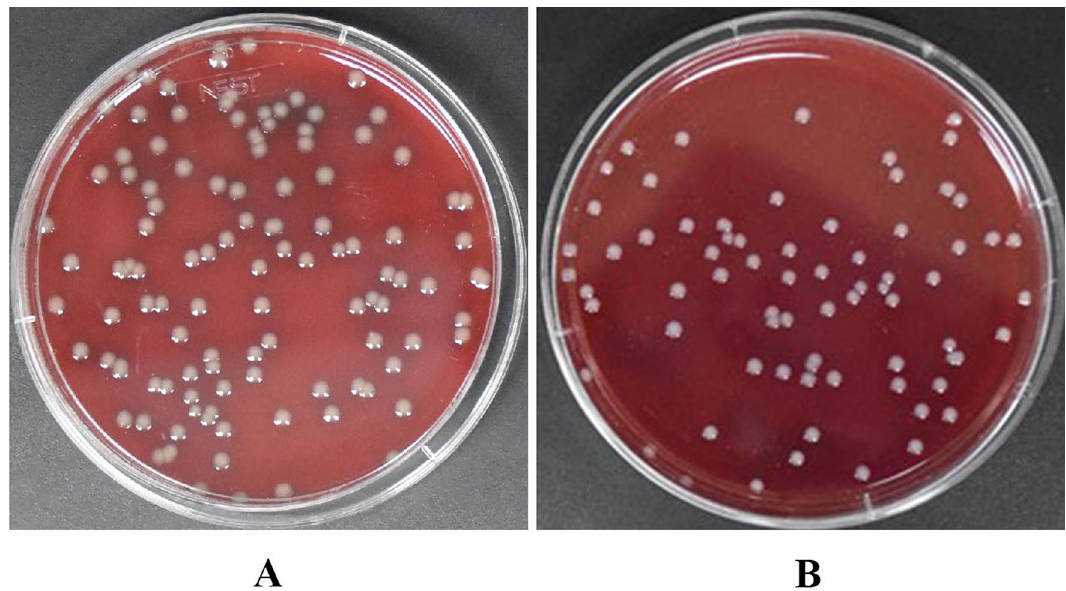
Figure 3. Bacterial culture and bacterial count. ( A ) colony number of Escherichia coli ATCC25922 is 107, ( B ) colony number of Staphylococcus aureus ATCC25923 is 70.